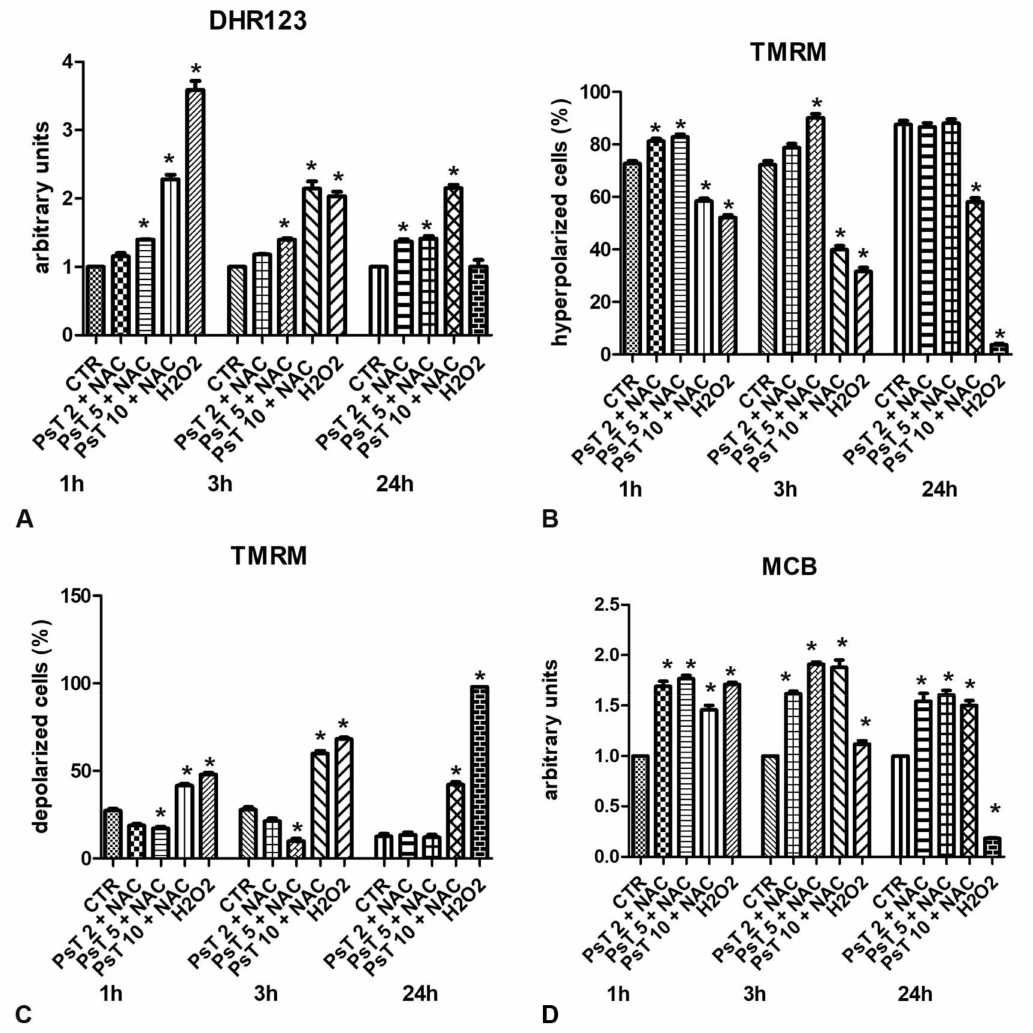
Figure 6. Flow cytometric analysis of oxidative stress after HCT116 cells treatment with increased concentration of Prunus spinosa extract plus nutraceutical activator complex (NAC) (PsT 2 mg/mL + NAC; PsT 5 mg/mL + NAC; PsT 10 mg/mL + NAC) for 1, 3 and 24h. ( A ) Superoxide content by dihydrorhodamine 123 (DHR123) probe; ( B ) hyperpolarized cell percentage by tetramethylrhodamine methyl ester (TMRM) cation probe; ( C ) depolarized cell percentage by tetramethylrhodamine methyl ester (TMRM) cation probe; ( D ) GSH content by monochlorobimane (MCB) probe. After treatment, cells were incubated with DHR123, or TMRM or MCB and then analyzed by a BDLSRII flow cytometer (Becton, Dickinson & Company, Franklin Lakes, NJ, USA). For detailed materials and methods see De Berardis et al., 2010 [73]. The results obtained